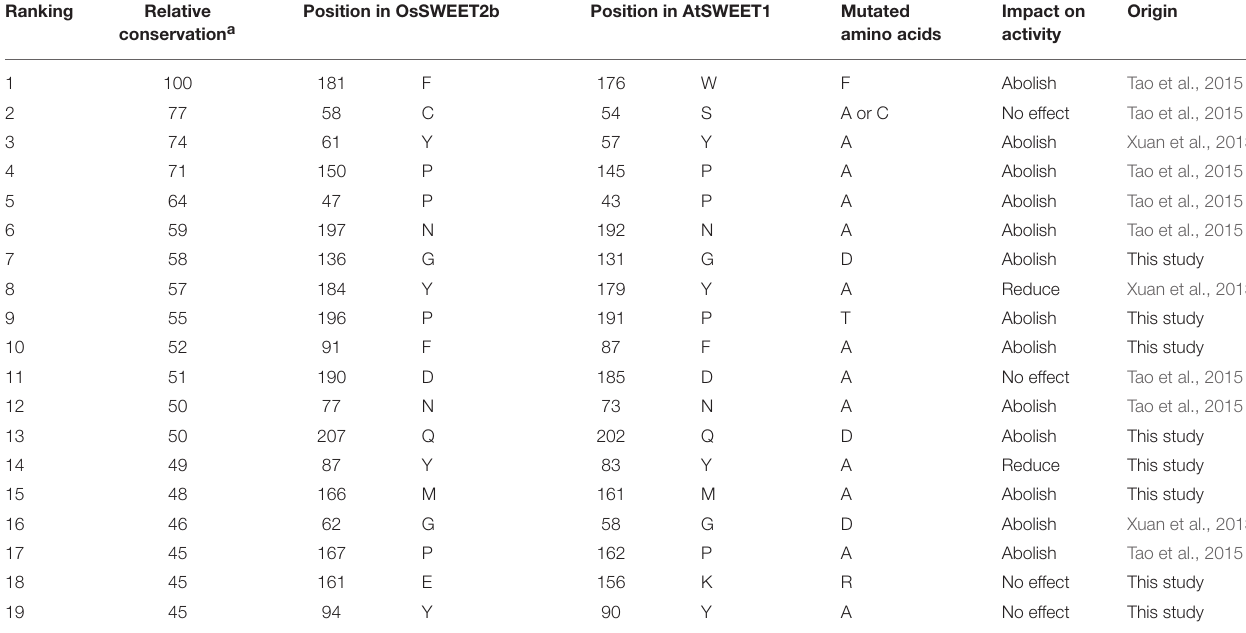
TABLE 1 | Effects of highly conserved residues on the activity of SWEET. Ranking Relative conservation